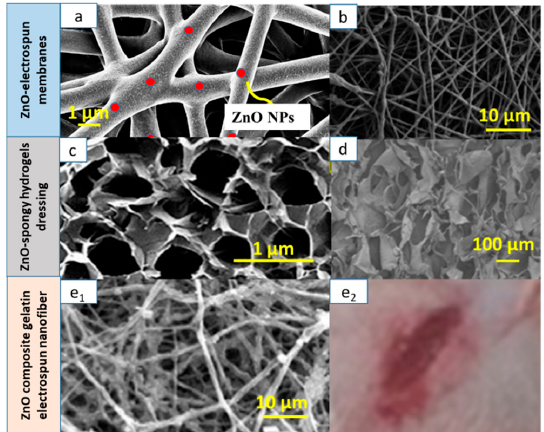
Figure 6. Wound-healing solutions. ( a ) Higher-magnification SEM micrograph of poly( ɛ - caprolactone) (PCL) membrane containing 1 wt.% ZnO nanoparticles, ( b ) SEM image of poly(3- hydroxybutyrate-co-3-hydroxy-valerate) (PHBV) reinforced with cellulose nanocrystal (CNC)–ZnO at weight loadings of 5%. ( c ) SEM image of keratin–chitosan-ZnO nanocomposite hydrogel. ( d ) SEM image of surface of chitosan (CS)–Ag/ZnO-1.0 (sponge immersed in 1.0 mg/mL of Ag/ZnO solution); ( e1 ) SEM image of cefazolin-loaded zinc-oxide nanoparticle composite gelatin nanofiber, and ( e2 ) dorsal skin region of rat embedded with the same nanofiber wound dressing.